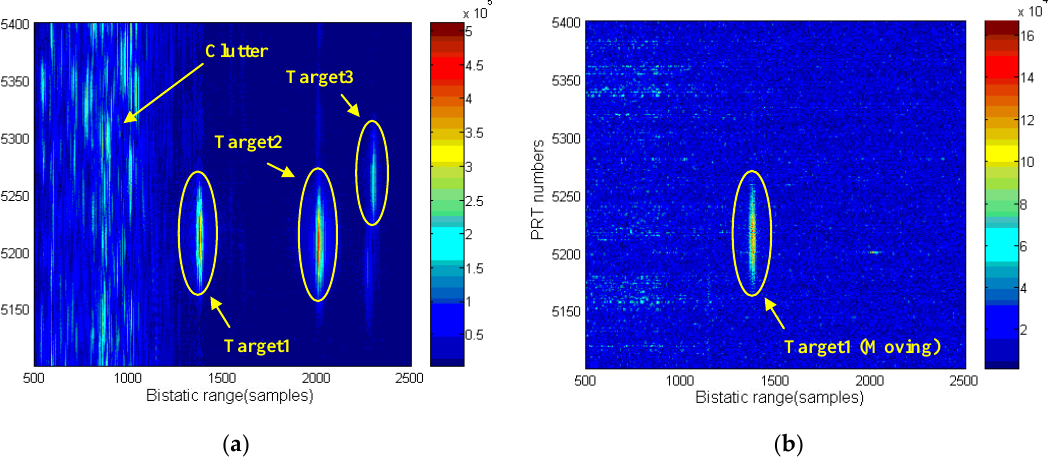
Figure 22. HBR map of the target area before and after MTI processing: ( a ) Before MTI processing; ( b ) After MTI processing.